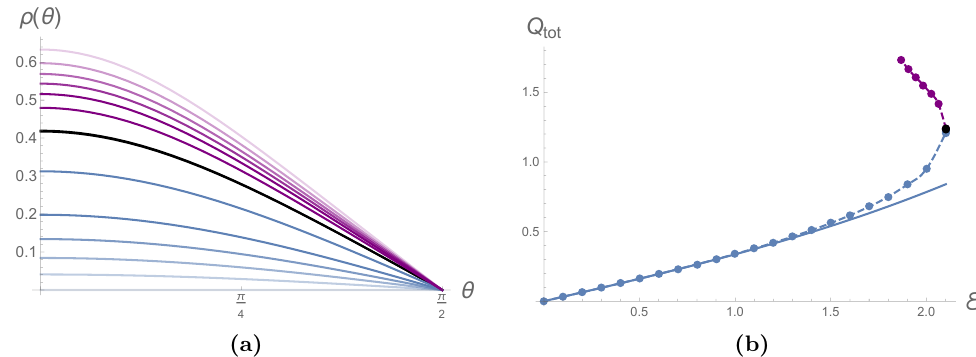
Figure 2. (a) The charge density and (b) the total charge on the AdS boundary for several values (cid:2) (cid:3) Sol of 0 ; with G N set to one. Blue and purple correspond to the two branches of the soliton, c E 2 E with the maximum value of the electric (cid:12)eld shown in black. The solid curve in (b) represents the analytical perturbative result in , as derived in appendix E